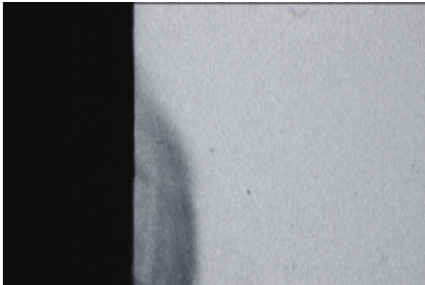
Figure 2: TMR image of a representative specimen after microbio- logical caries induction.